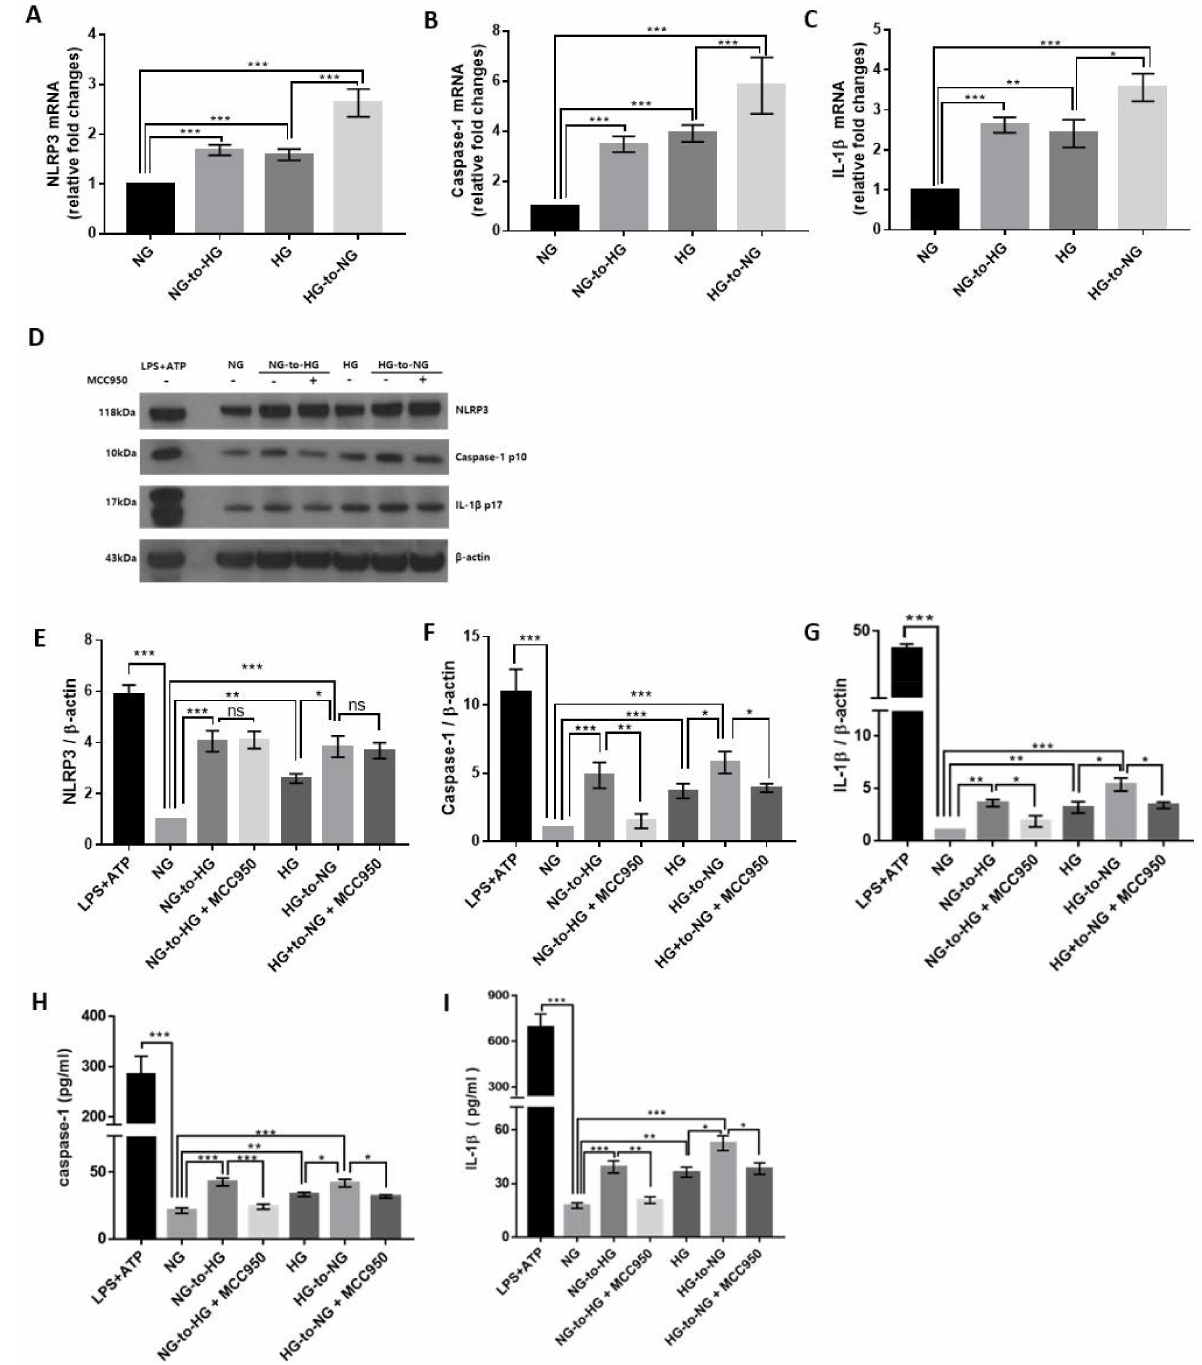
Figure 2. Acute glucose shift induces the activation of the NLRP3 inflammasome in THP-1 cells. The media of THP-1 cells assigned as NG- and HG-cultured cells were changed into HG and NG media, as indicated. ( A – C ) The mRNA levels of NLRP3, caspase-1, and IL-1 β were examined by real-time quantitative PCR. ( D ) Cell lysates were subjected to western blotting using antibodies against NLRP3, caspase-1, and IL-1 β . THP-1 cells were pretreated with MCC950 (10 µ M) for 2 h and then exposed to acute glucose shift for 24 h. For positive control, THP-1 cells were treated with LPS (1 µ g/mL) for 4 h and with 5 mM ATP for the last 30 min. ( E – G ) The protein expression levels of NLRP3, caspase-1, and IL-1 β were quantified using Image J software. ( H , I ) The levels of caspase-1 and IL-1 β in the culture supernatant were determined using ELISA. Data are presented as the mean ± SEM from at least three independent experiments. * p < 0.05, ** p < 0.01, *** p < 0.001, ns, not